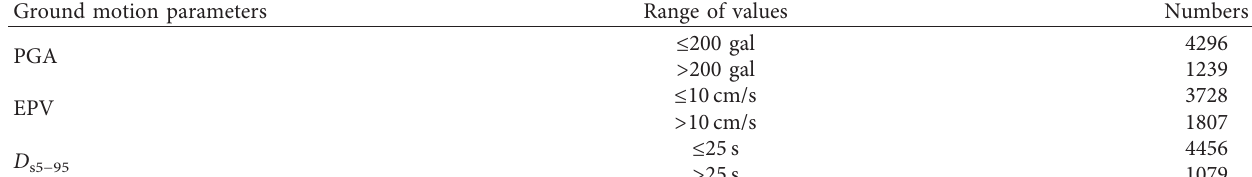
Table 5: Classification results of ground motion records based on ground motion parameters.